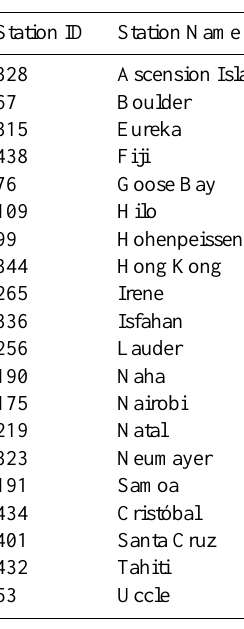
Table 2. Geolocation of the 20 stations for